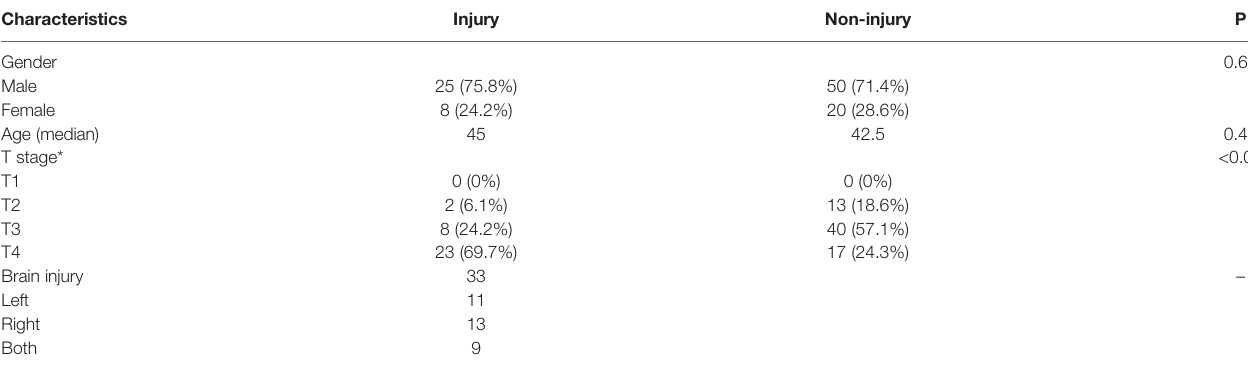
TABLE 1 | Basic characteristics for 103